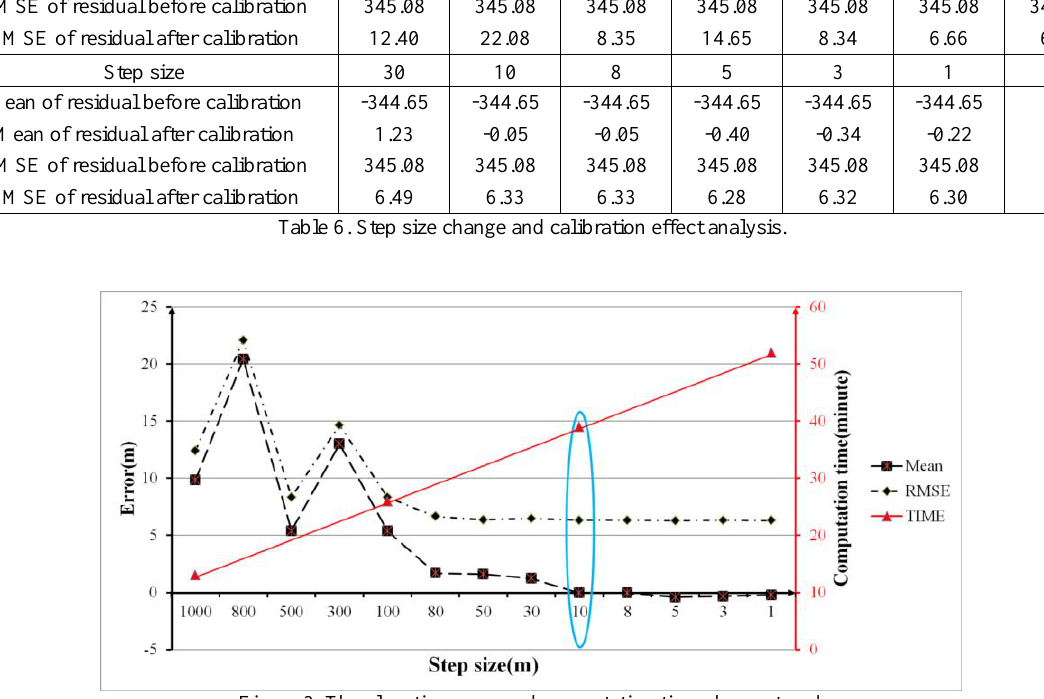
m, the best step size for matching search is 10 m. We hope more accurate DEM data can be obtained to verify and further analyze the influencing factors for curve matching based geometric calibration